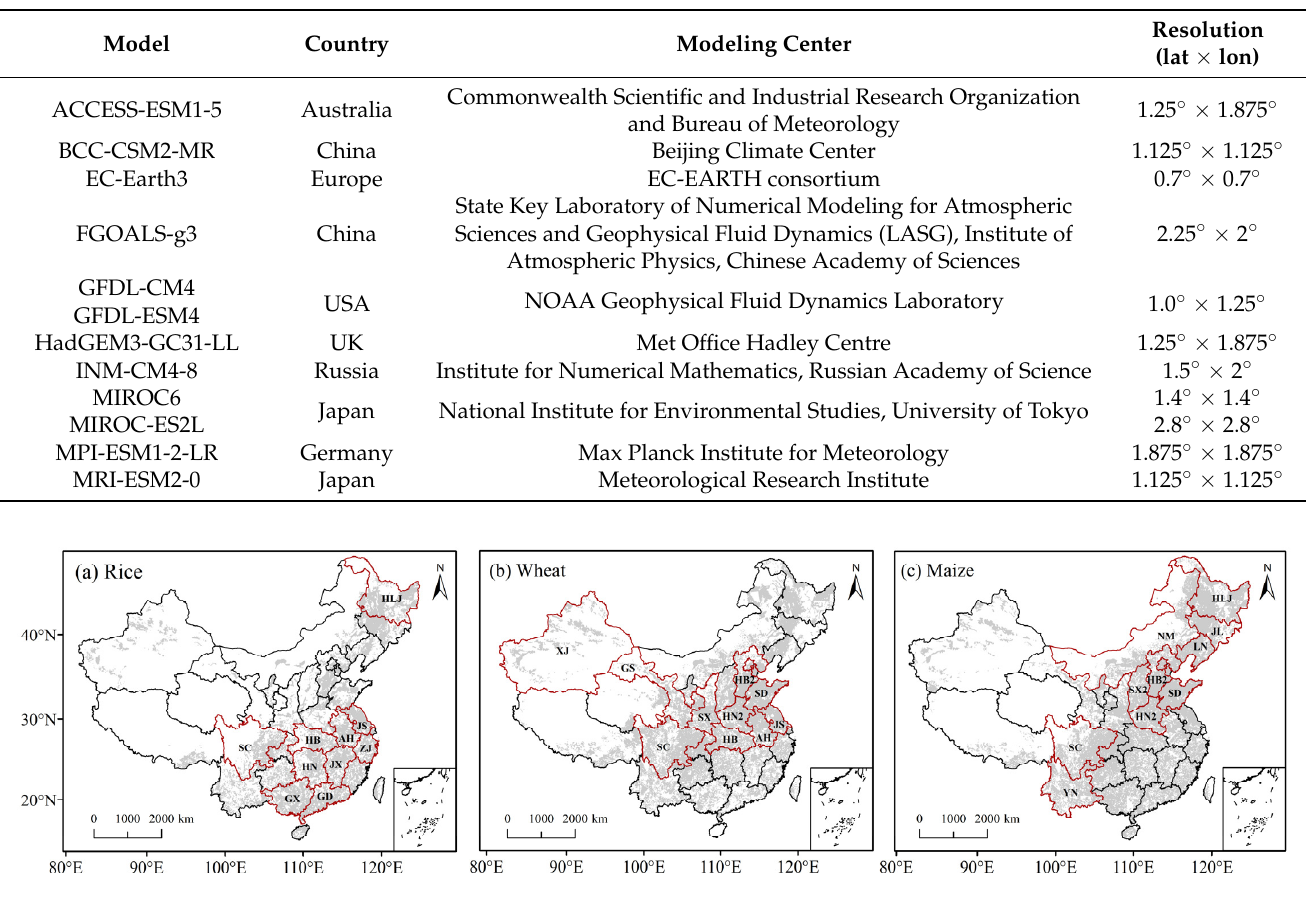
Table 2. Information of 12 CMIP6 models used in this study.